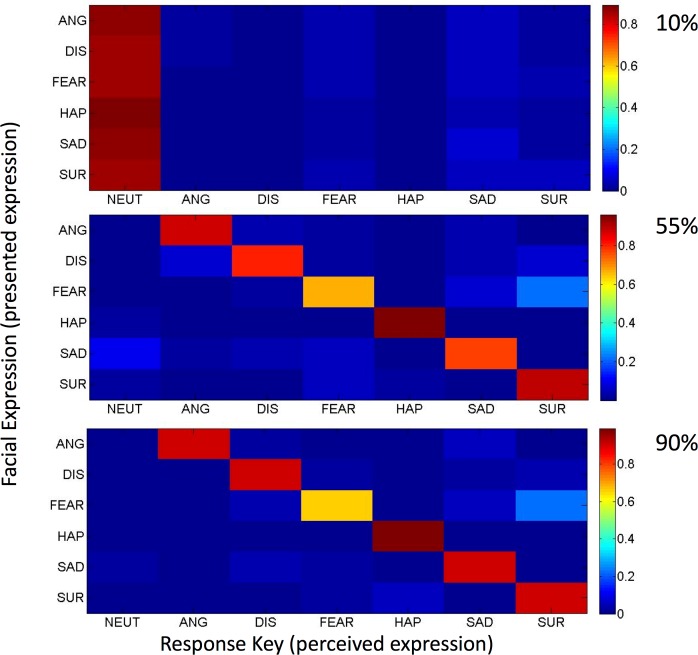
Confusion matrixes showing the percentage of participants’ responses to all six emotions for 10% (A), 55% (B) and 90% (C) intensities.